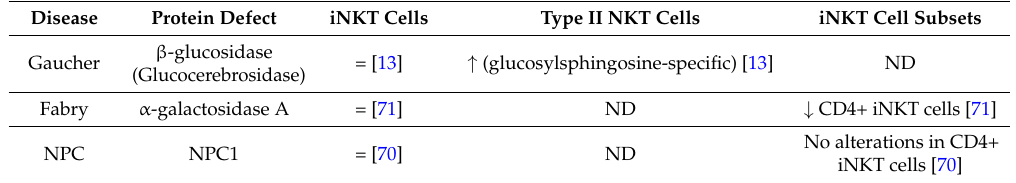
Table 3. NKT cells in Lysosomal Storage Diseases (LSDs)